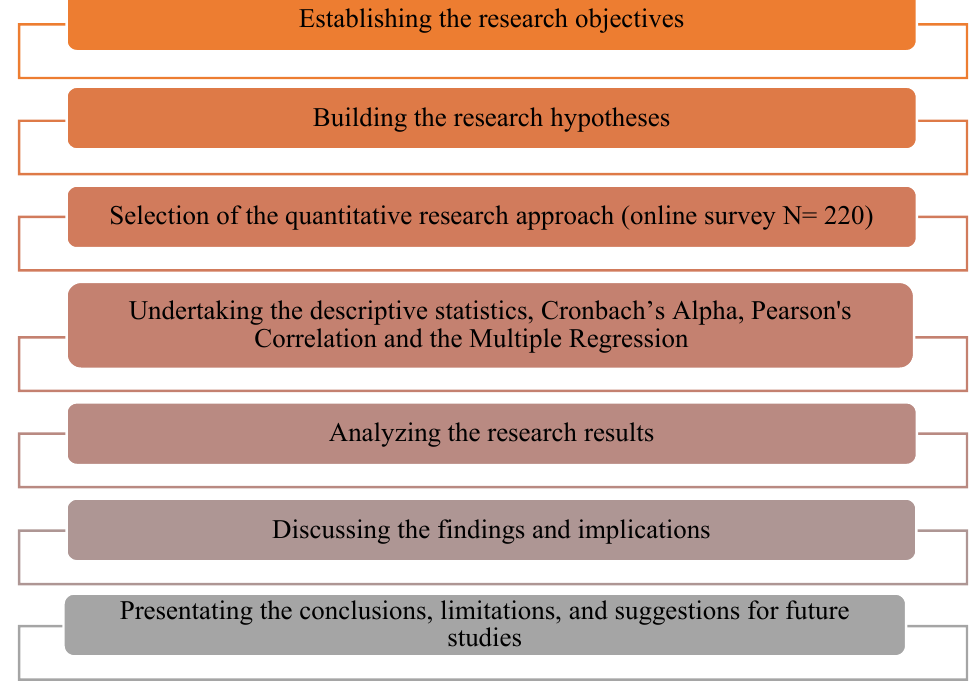
Figure 2. The research process.